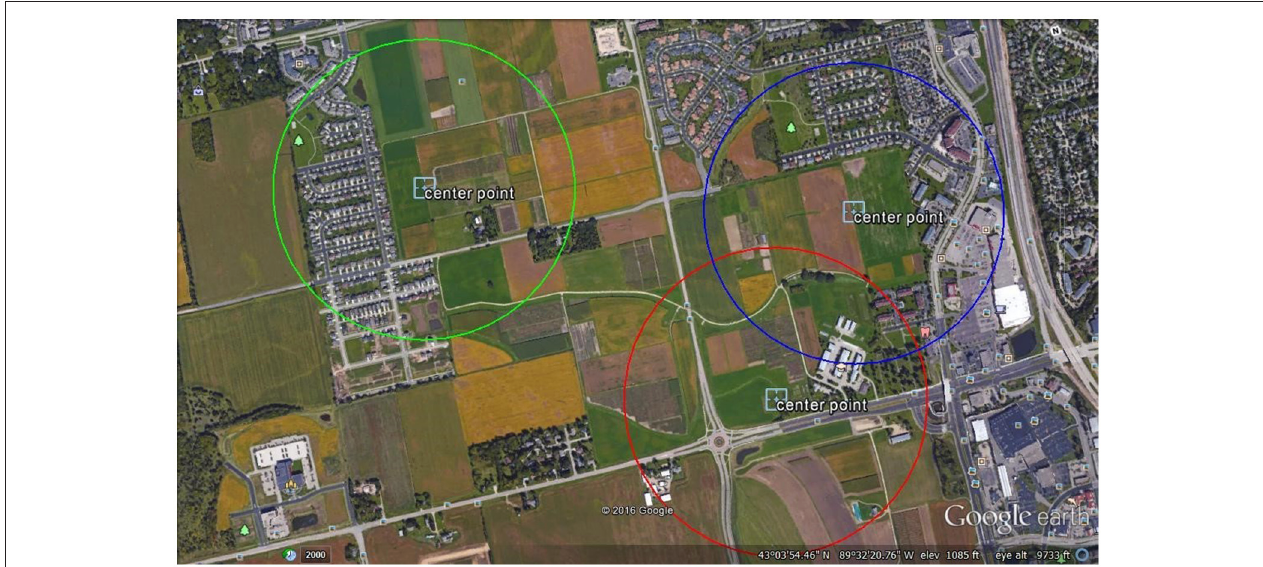
FIGURE 1 | Aerial screenshot of the site locations. One honey bee and one bumble bee hives were located in the middle of each circle depicted as a 0.5km radius at each location.